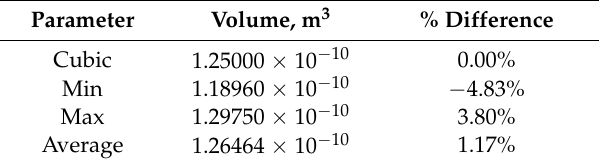
Figure 3. A model of a rail: ( a ) an Ansys model with solid elements; ( b ) peridynamic (PD) mesh-free discretization with the load area highlighted. discretization with the load area highlighted. Table 1. The cubic versus the smallest, largest, and average node volume. Table 1. The cubic versus the smallest, largest, and average node